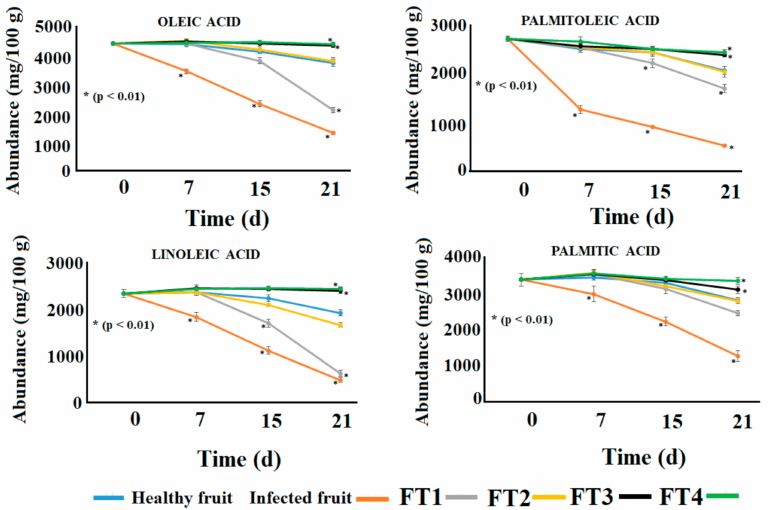
Figure 6. Fatty acid content of avocadoes treated with the films FT1–FT4 after inoculation with Clonostachys rosea . Points with asterisks indicate means with statistically significant differences by ANOVA-Tukey test in comparison with healthy fruits ( p <